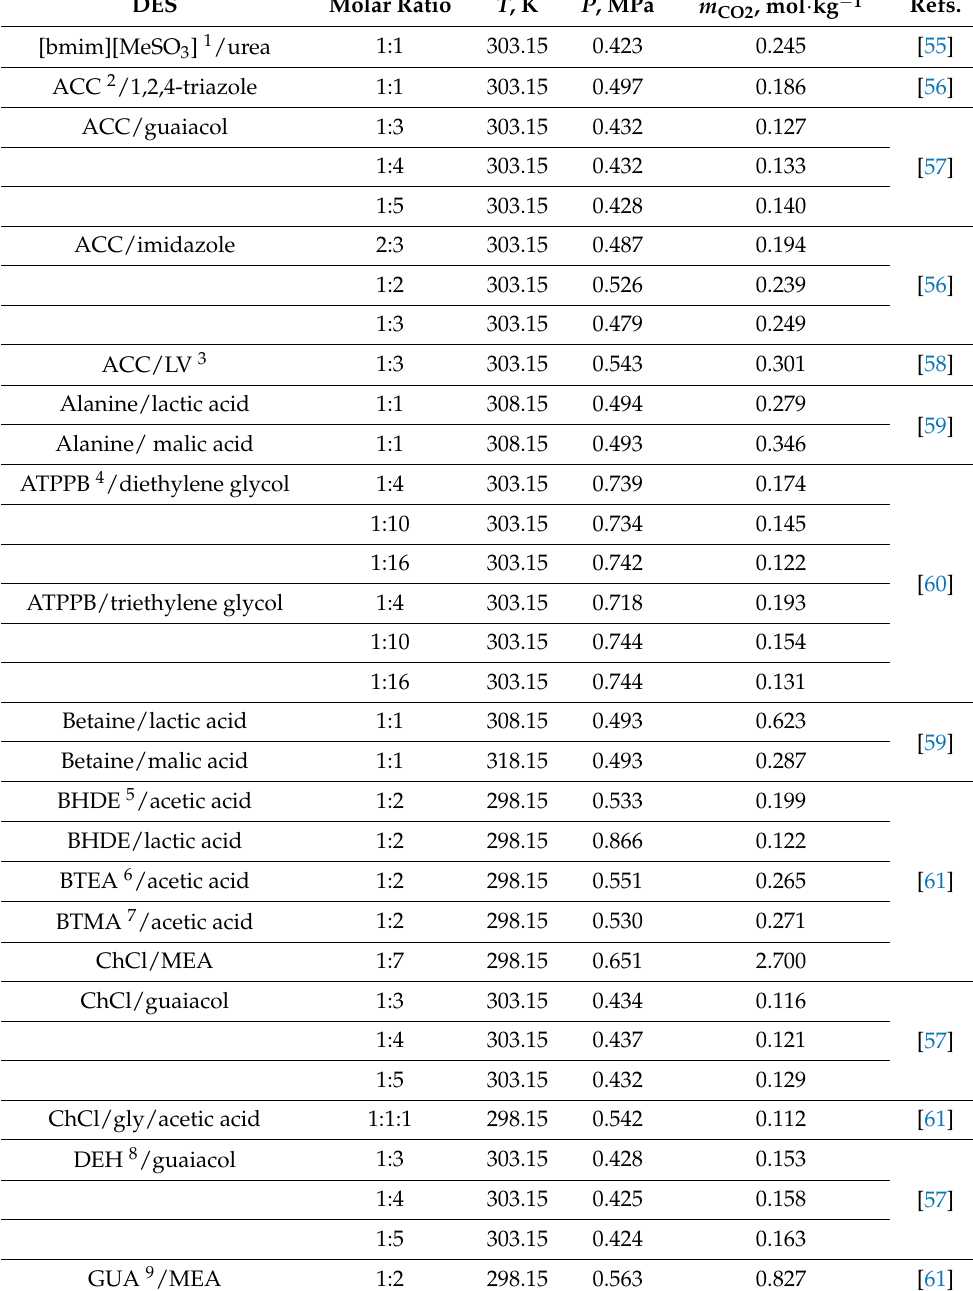
Table 1. Solubility ( m CO2 ) of CO 2 in DESs at different temperatures and pressure. DES Molar